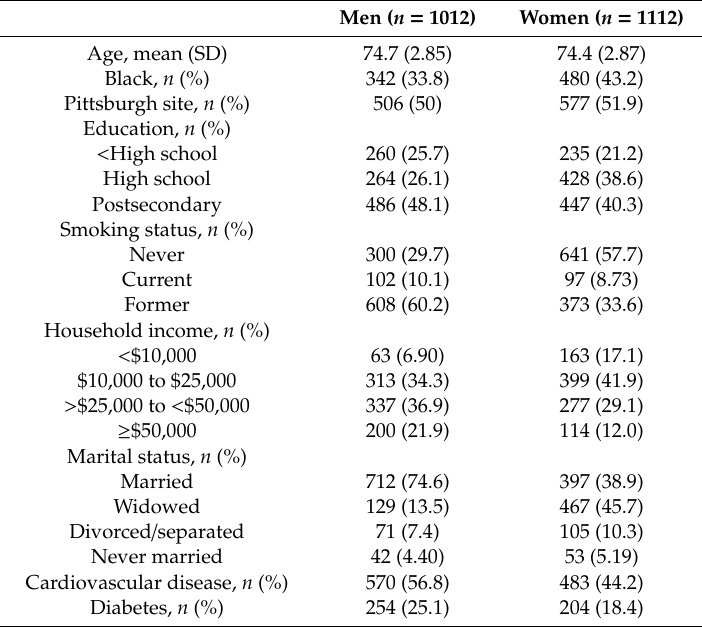
Table 2. Characteristics of participants in the Health ABC Study by sex.